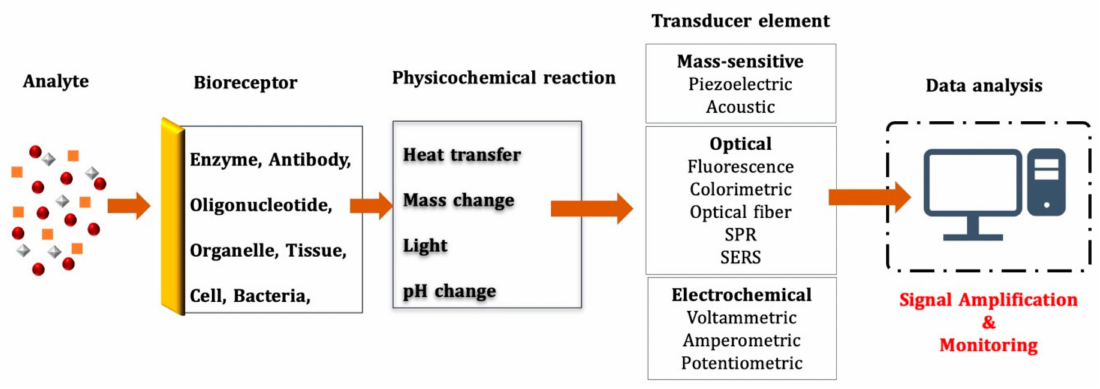
Figure 1. The classic biosensor